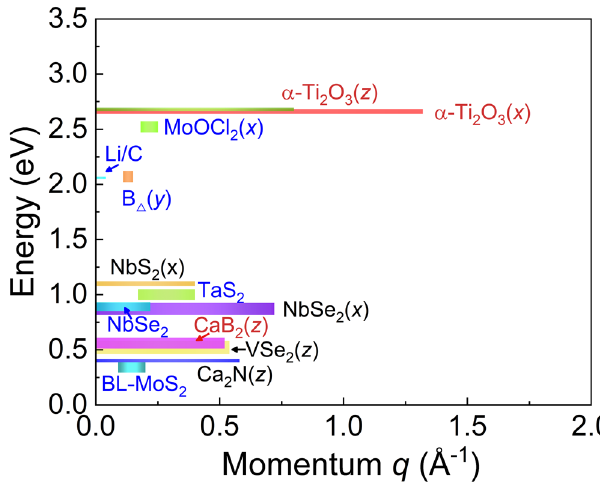
Fig. 5 | The superiority of the plasmons in α -Ti 2 O 3 . Comparison with other materials 18,50 – 57 that have a relatively fl at plasmon modes ( Δω p <0.1eV). The length of the bar represents the start/end momentum of the fl at plasmons. The width of thebarrepresentsthe fl atnessoftheplasmonmode Δ ω p .Wordsusingred,blueand black colors represent the three-dimensional, two-dimensional (monolayer or double layers) and bulk layered materials, respectively.